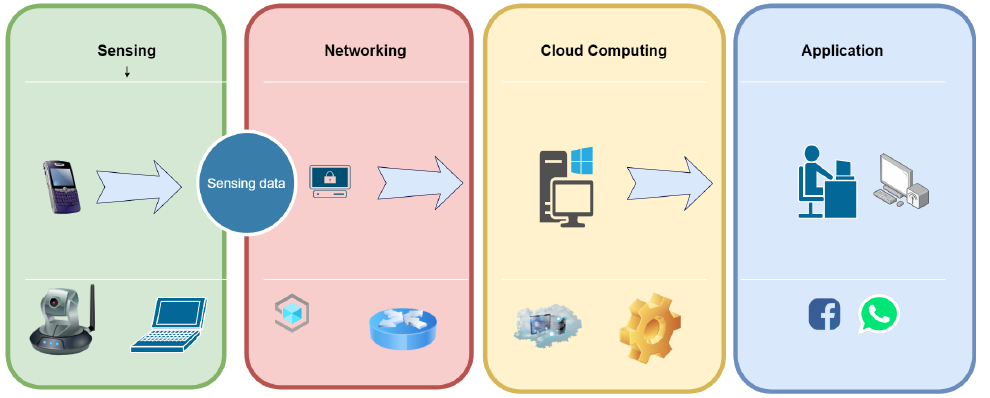
Figure 2. Heterogeneous IoT